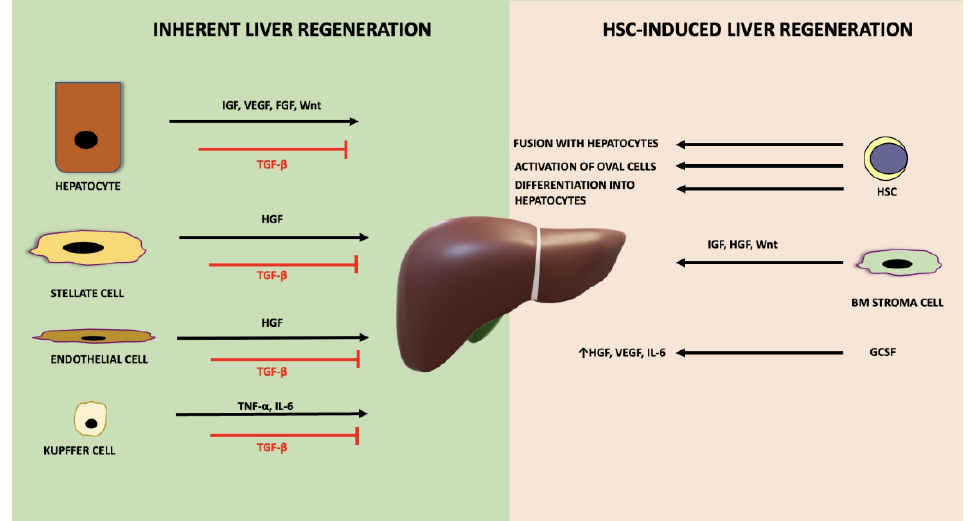
Figure 3. The mechanisms of inherent versus HSC-induced liver regeneration. Information from animal studies have indicated the contribution of various liver cell types (hepatocytes, stellate cells, endothelial cells, Kupffer cells) and factors (HGF, IGF, VEGF, FGF, TNF- α , IL-6, Wnt factors) in inherent liver regeneration. The hematopoietic system contributes to liver regeneration through factor secretion, activation of oval cells, differentiation into hepatocytes and fusion of HSCs with resident hepatocytes. GCSF also has an impact on liver regeneration by increasing HGF, VEGF and IL-6 levels. IGF = insulin growth factor, HGF = hepatocyte growth factor, VEGF = vascular endothelial growth factor, TNF- α = tumour necrosis factor alpha, IL -6 = interleukin 6 (IL-6), TGF- β = transforming growth factor beta, FGF = fibroblast growth factor, GCSF = granulocyte-colony stimulating factor.